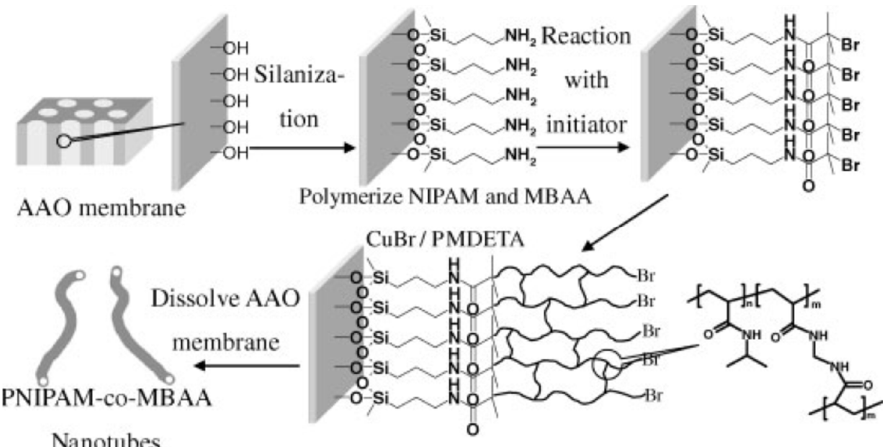
Figure 11. Schematic illustration of the fabrication of PNIPAM nanotubes in a porous AAO mem- brane [137]. Copyright 2005. Reproduced with permission from the publisher: Wiley.